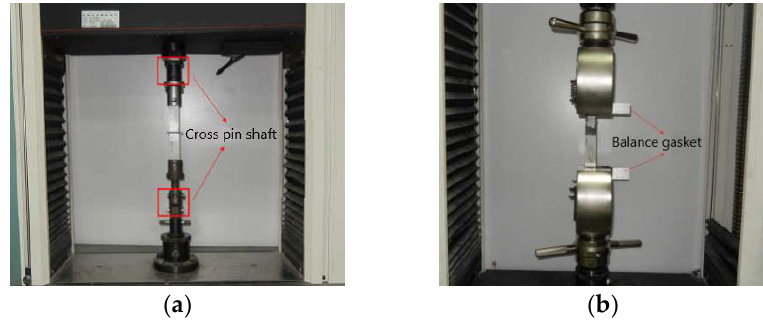
Figure 10. Performance test: ( a ) Butt tensile test; ( b ) Lap shear test.